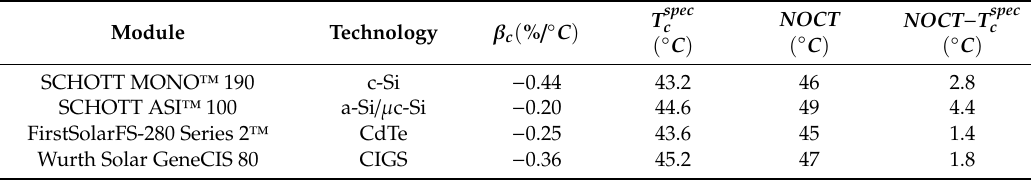
Table 3. Module type and